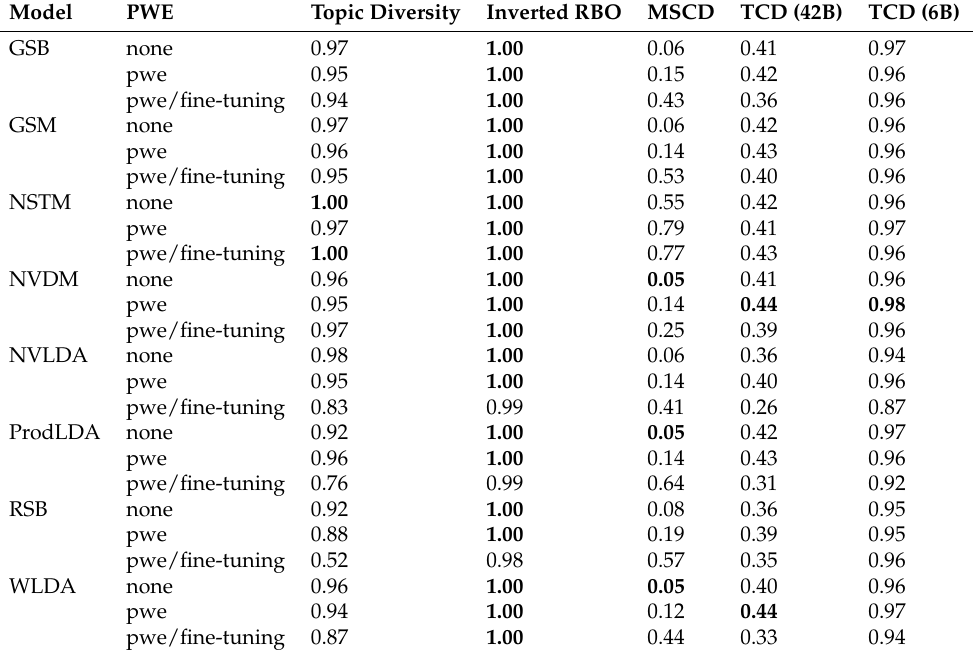
Table 22. Topic Diversity on